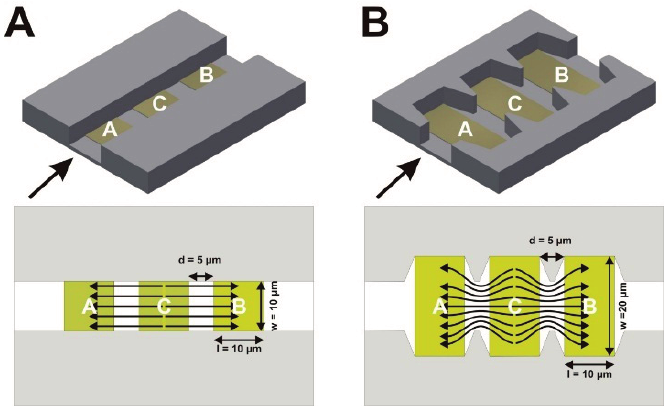
Figure 1. 3D schematic drawing of the electrode layout. ( A ) The conventional chip